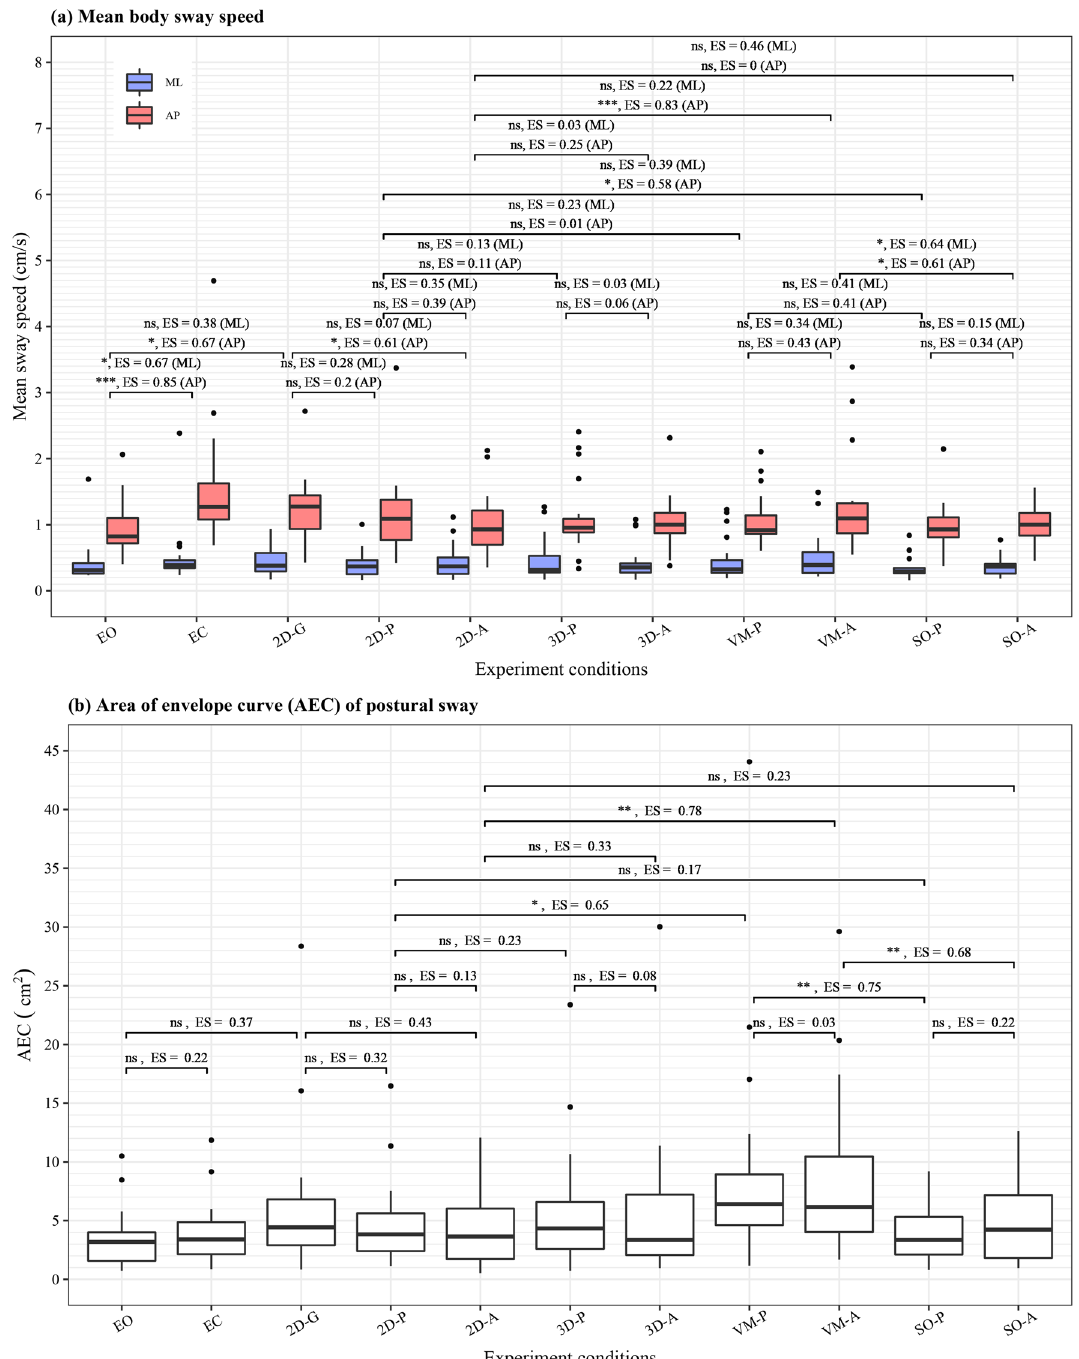
Figure 3. Distribution of postural sway in each test condition. ( a ) Mean postural sway speed, ( b ) AEC of postural sway in eyes-open, eyes-closed, 2D (baseline dual task condition), 3D (with visual challenge), visuospatial memory (VM), and spatial orientation (SO) VR environments. Significant differences were mainly seen in sway speed in anterior–posterior direction between (1) 2D-A and VM-A and (2) 2D-P and SO-P conditions. EO eyes-open, EC eyes-closed, P pro-saccade, A